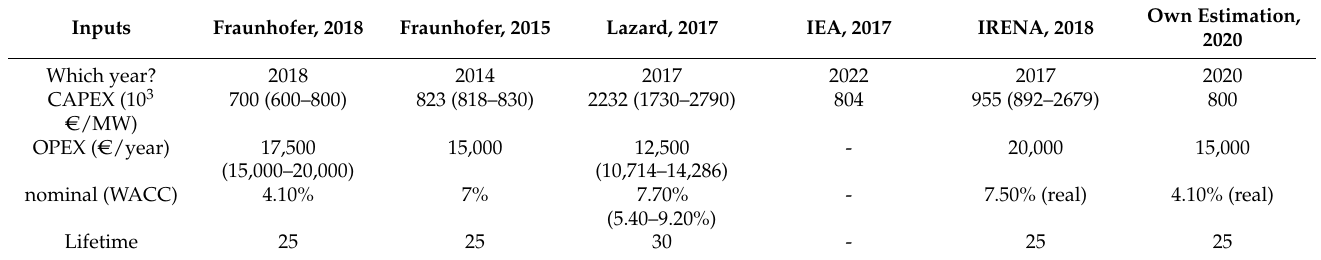
Table 1. Inputs and assumptions from the literature and for my own calculation, in brackets the minimum and maximum values, source: